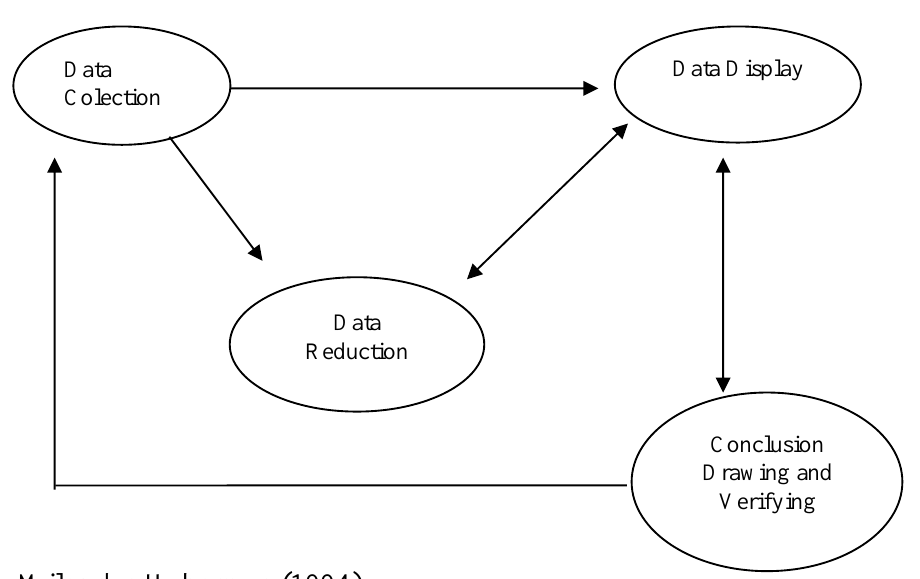
Figure 1.1 Data Analysis